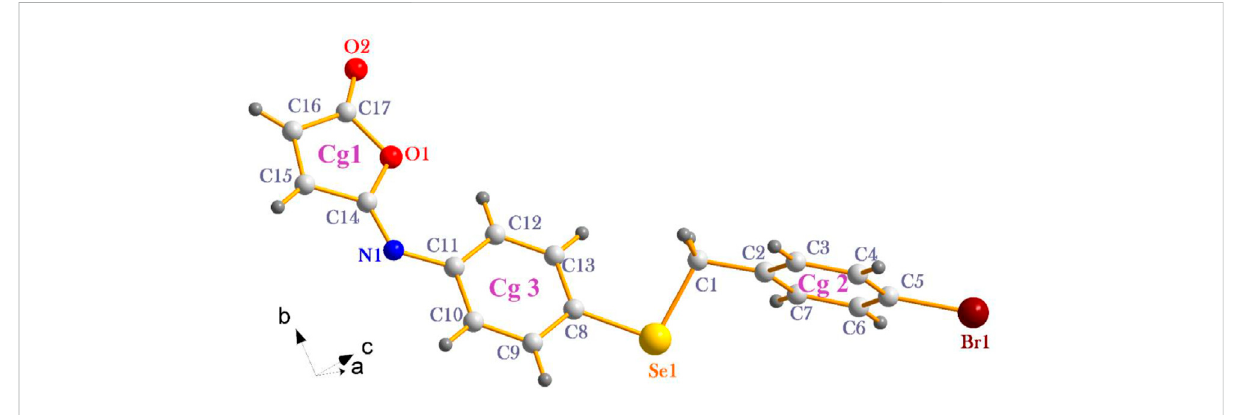
FIGURE 1 The molecular structure of isomaleimide 4 with atomic